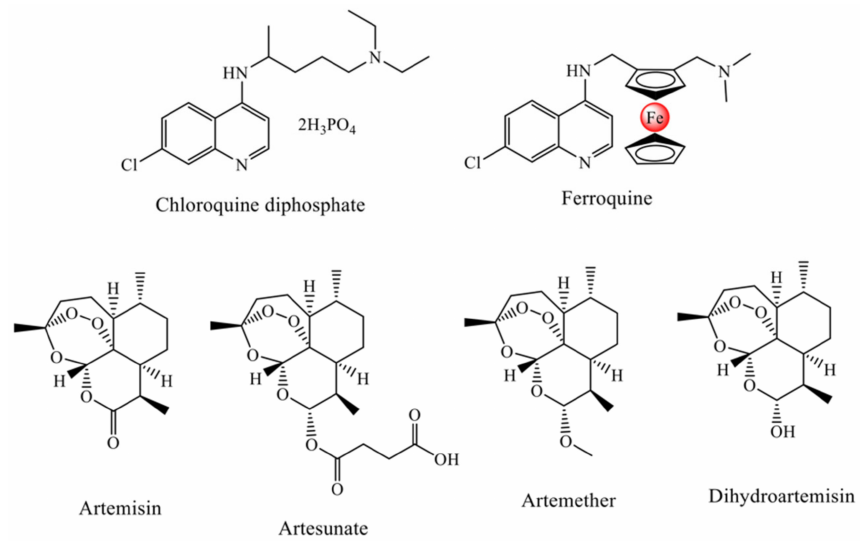
Figure 1. Drugs recommended by the WHO for malaria treatments and ferroquine (Phase